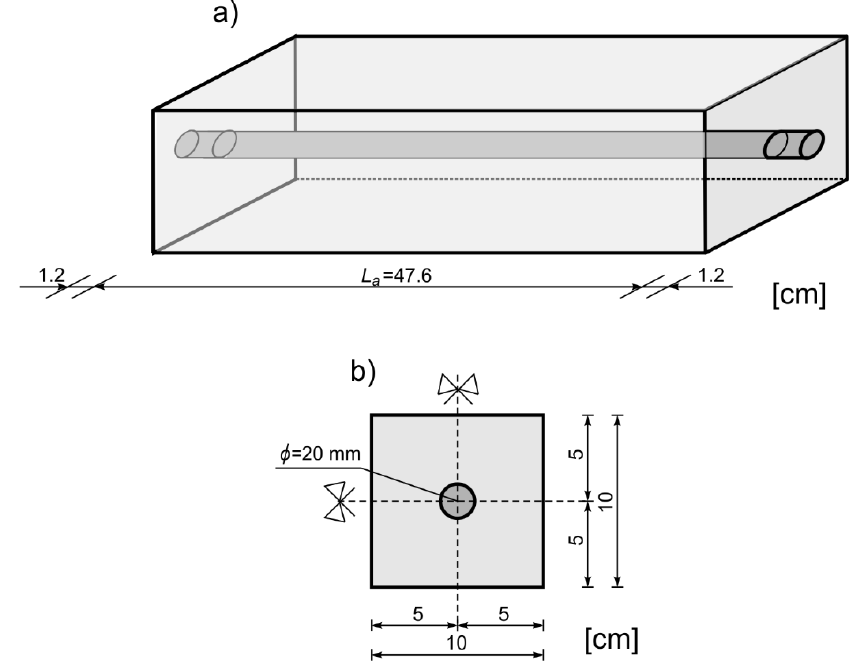
Figure 4. Experimental specimens : ( a ) geometry and ( b ) cross-section of the beam.